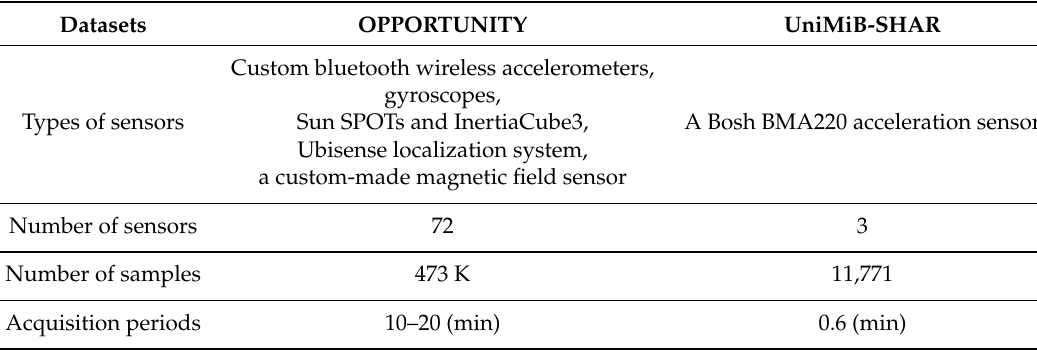
Table 3. The details of the experimental datasets.